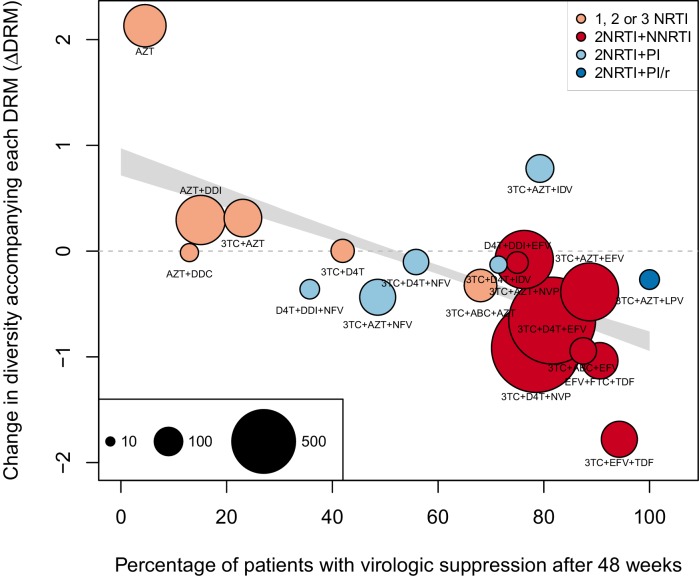
Nonparametric test shows negative correlation between treatment effectiveness and ΔD⁢R⁢M.Negative relationship between treatment effectiveness (percentage of patients with virologic suppression after ~48 weeks) and ΔD⁢R⁢M as fit within the GLMM among all treatments for which we have recorded effectiveness information. Treatments included are plotted at the mean ΔD⁢R⁢M from GLMMs fit to 1000 iterations of data subsampling. Points for each treatment are sized in proportion to the number of sequences from patients given that treatment (see legend in the lower left), and are colored based on the treatment type (see legend in the upper right). The black line shows the mean effect of treatment effectiveness on ΔD⁢R⁢M from linear regressions fits to the 1000 subsampled datasets and the grey band shows a 95% confidence interval (excluding the top and bottom 2.5% of fits).